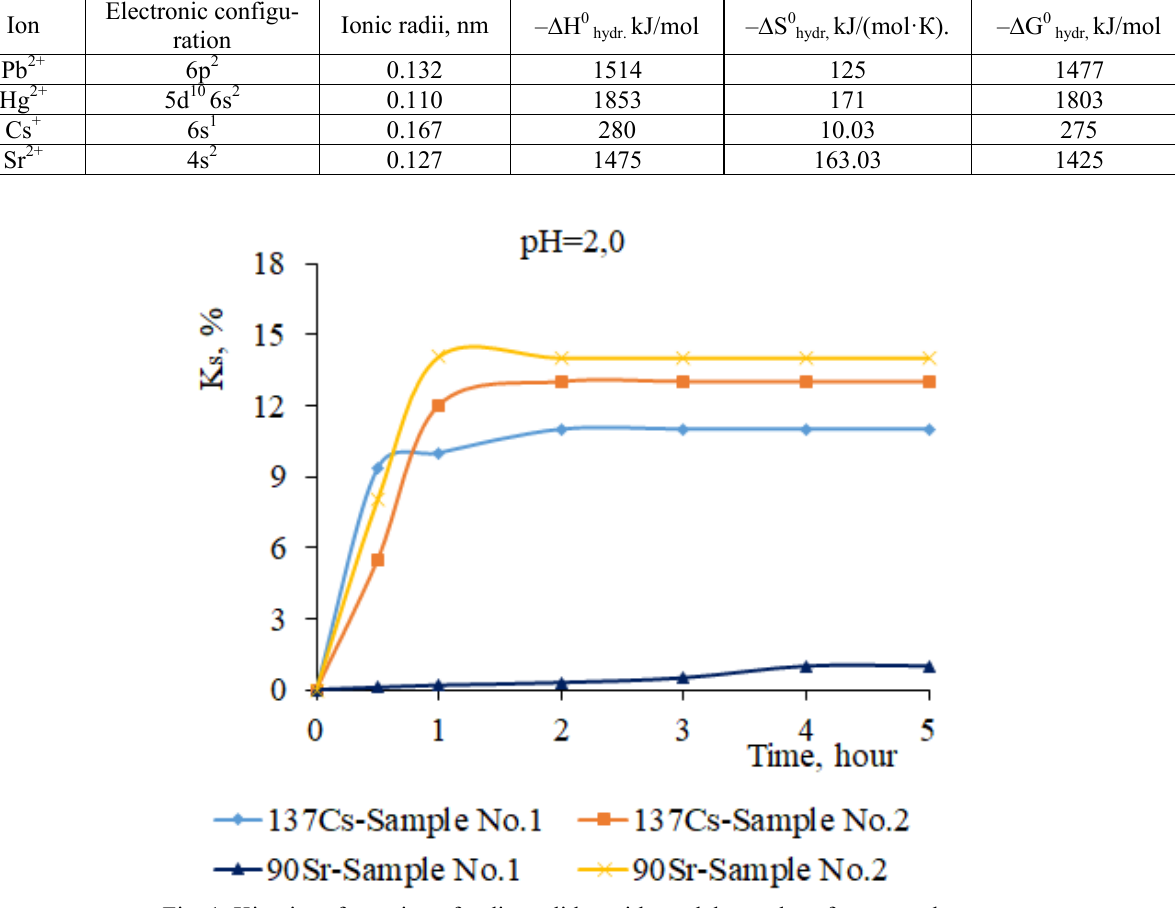
Fig. 1. Kinetics of sorption of radionuclides with model samples of